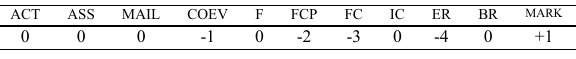
Table 11. FIR optimal mask (fuzzification parameters defined by the GA).